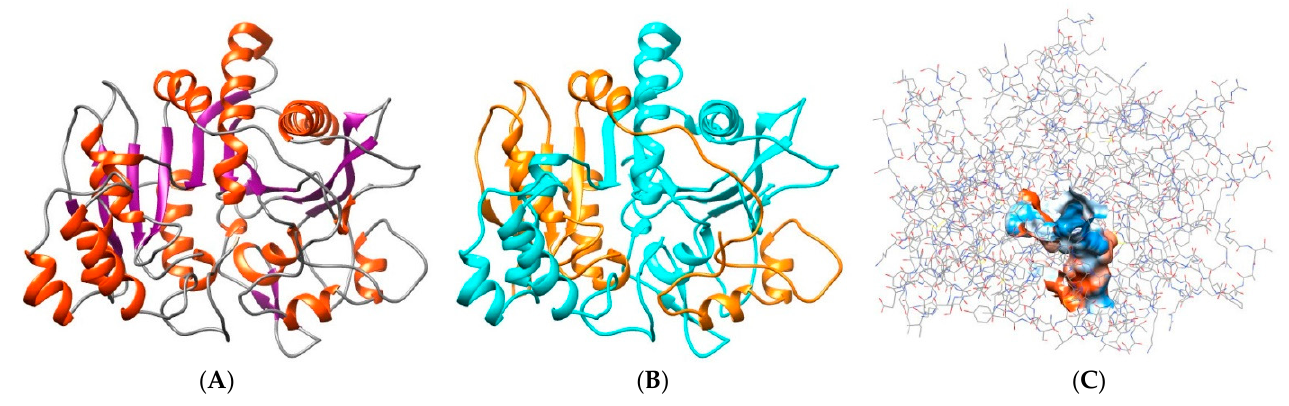
Figure 3. Depiction of the best 3D model for the mature Nf 314 enzyme. Ribbon representation, colored according to ( A ) secondary structure, α -helix in red and β -sheet in purple), or ( B ) polypeptide chains produced after putative propeptide processing, large in cyan and small in orange. ( C ) Wire representation, colored by the element, highlighting the specific location of the predicted ligand-binding pocket (surface colored by hydrophobicity).